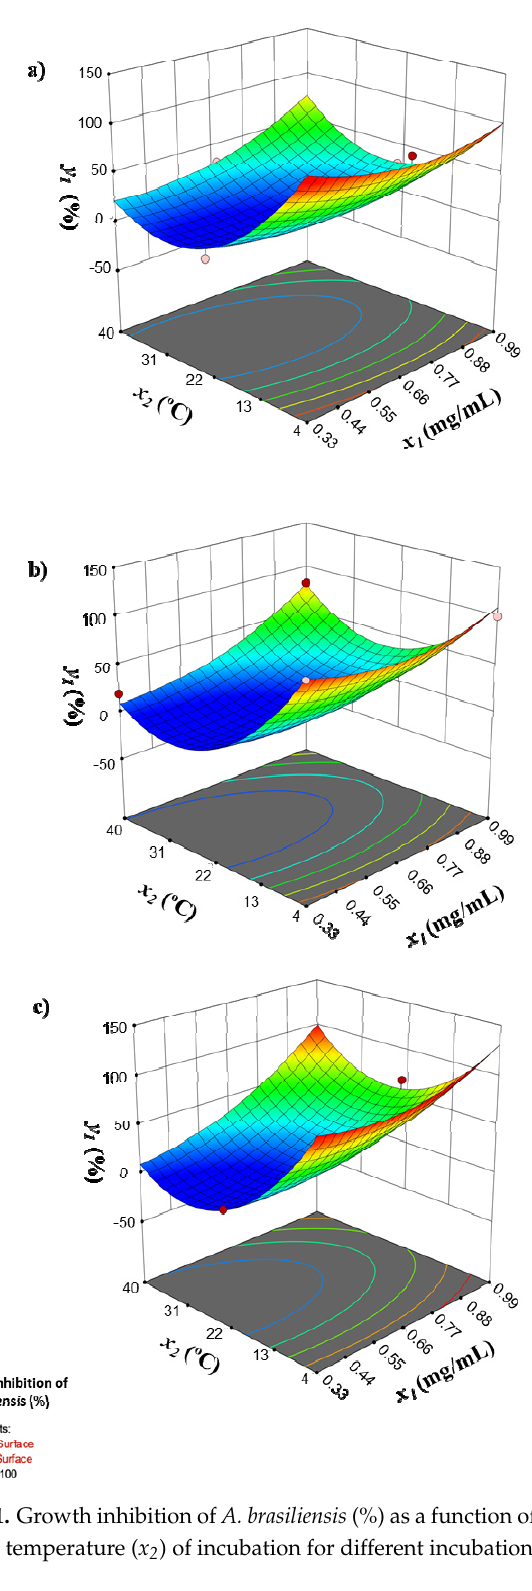
Figure 1. Growth inhibition of A. brasiliensis (%) as a function of the concentration of the biosurfactant ( x 1 ) and temperature ( x 2 ) of incubation for different incubation times ( x 3 ): ( a ) 5, ( b ) 8 and ( c ) 11 days.